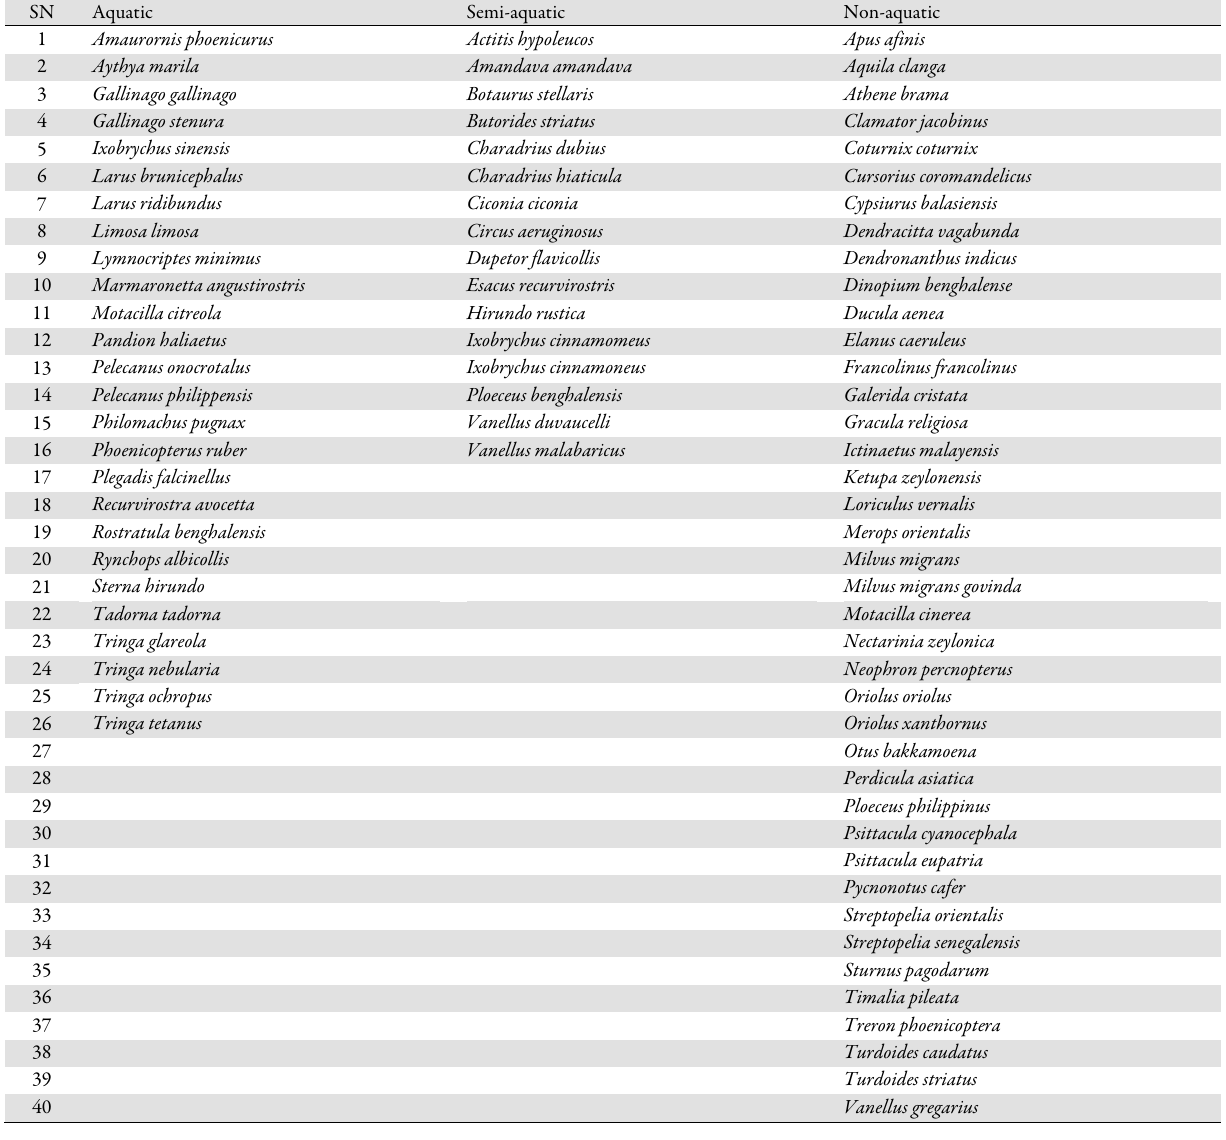
Table 5. List of the birds of occasional occurrence (1-3) across the protected wetlands of Uttar Pradesh